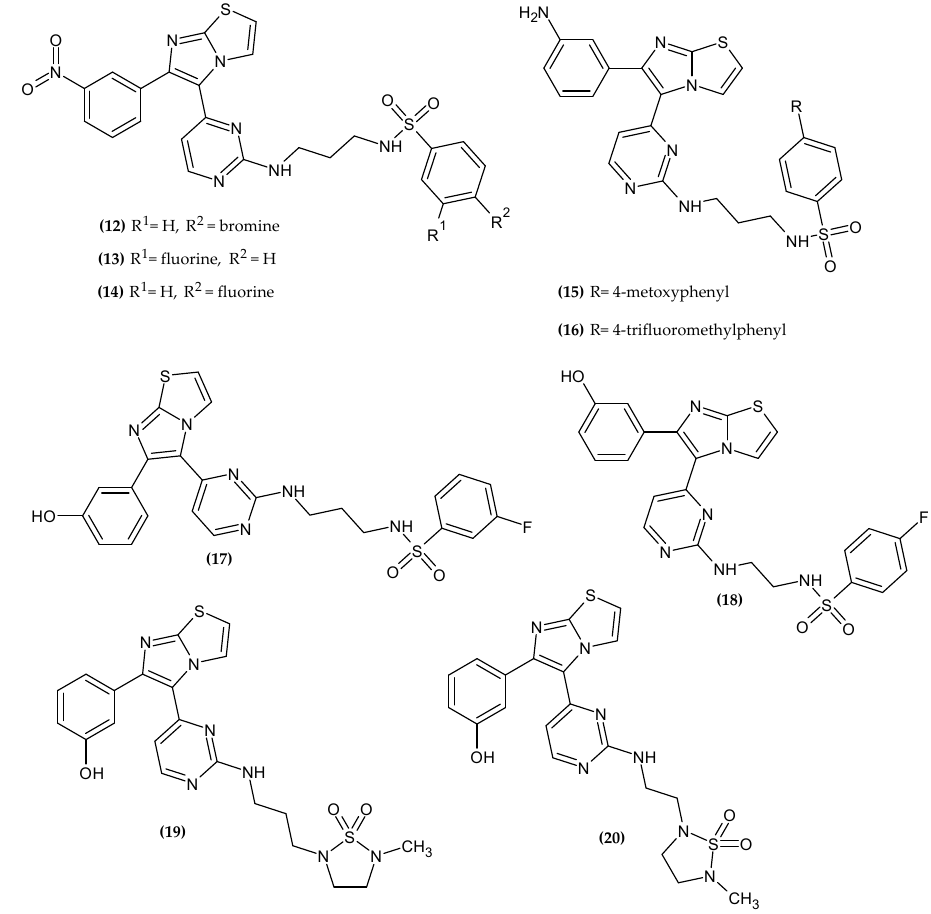
Figure 4. Imidazothiazole derivatives with anti-melanoma activity.